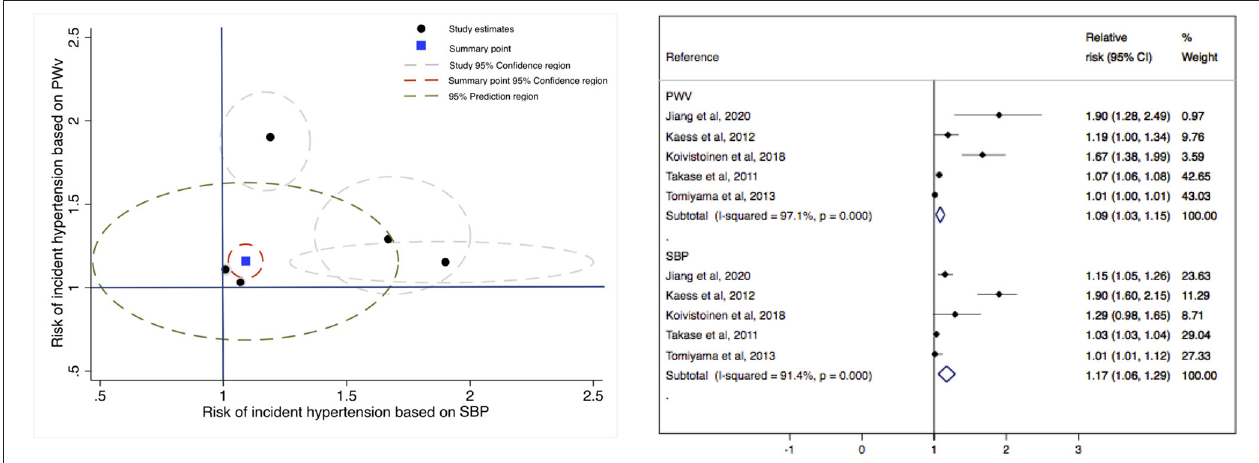
FIGURE 3 | Comprehensive scatterplot for the risk of incident hypertension based on systolic blood pressure (x-axis) and on pulse wave velocity (y-axis).